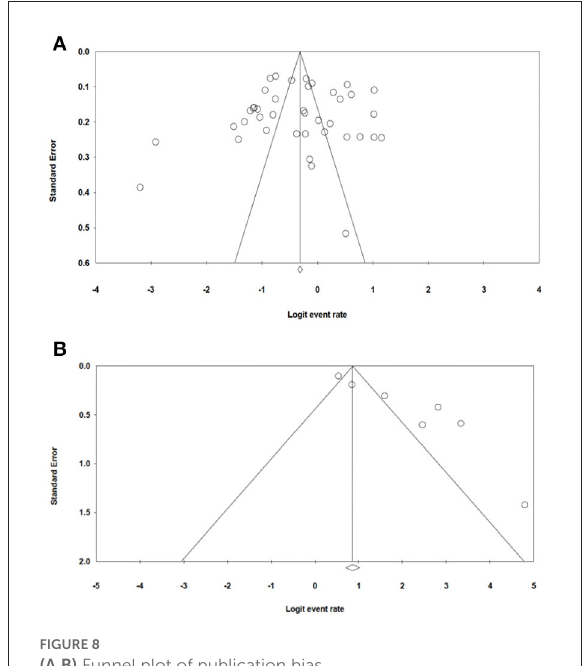
FIGURE8 (A,B) Funnel plot of publication